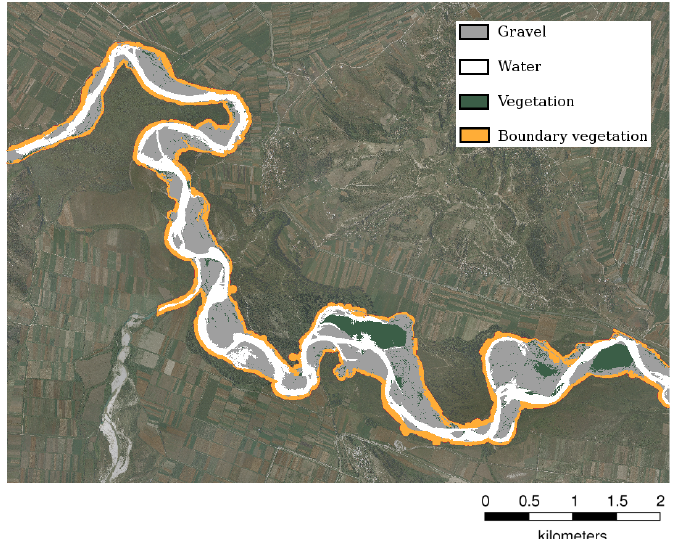
Figure 4. Example of classified surface coverage